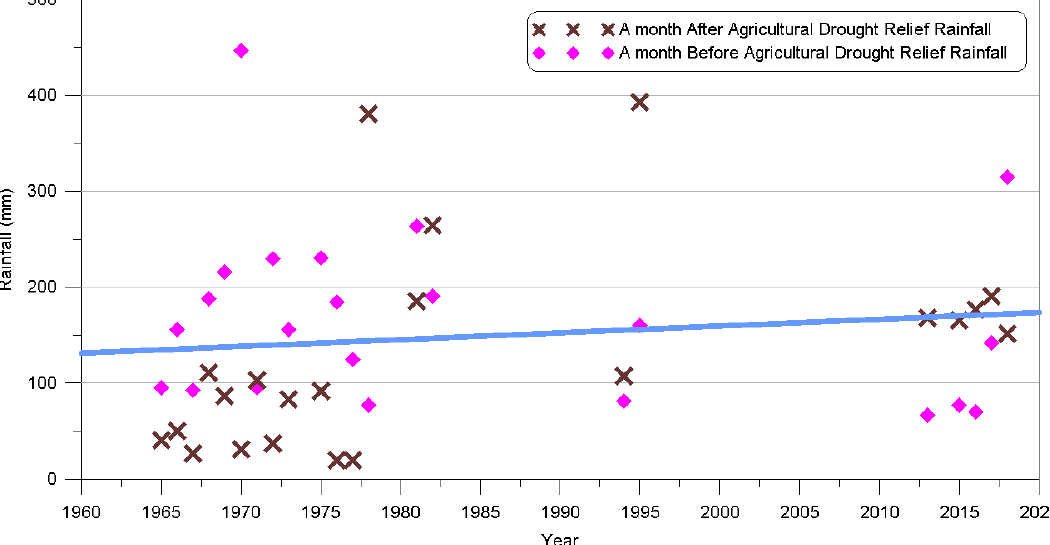
Figure 10. Setting up rainfall for disaster reduction relevant to agricultural droughts by year.